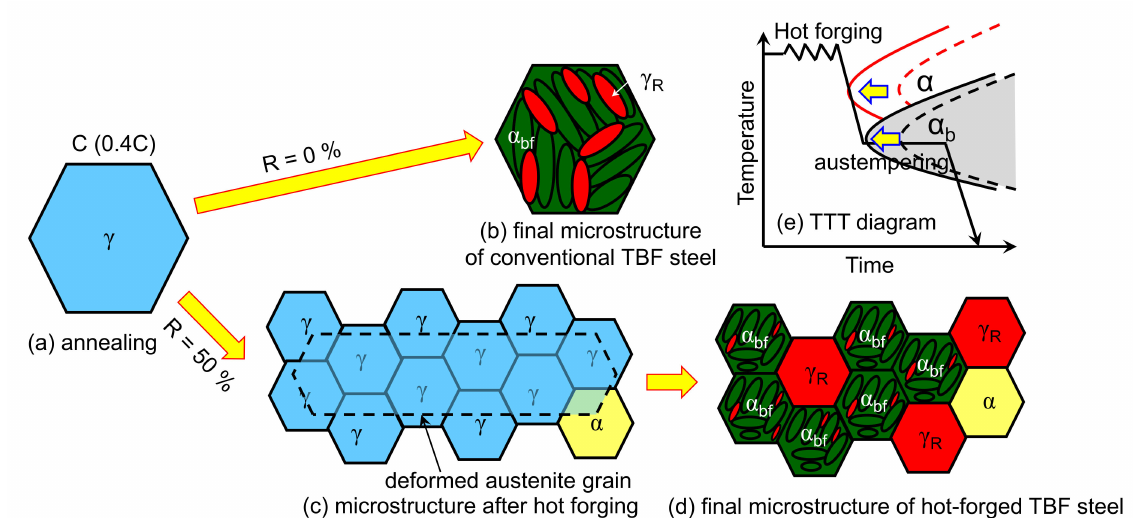
Figure 12. Illustrations of microstructure evolution behavior of hot-forged steel C. ( a ) Austenite at annealing temperature, ( b ) final microstructure of conventional TBF steel, ( c ) microstructure after hot forging, ( d ) final microstructure of hot-forged TBF steel, ( e ) TTT diagram, respectively. R represents reduction ratio. α , α b , α bf , γ , and γ R denote ferrite, bainite, bainitic ferrite, austenite, and retained austenite, respectively. The TTT diagram ( e ) is the time transition temperature